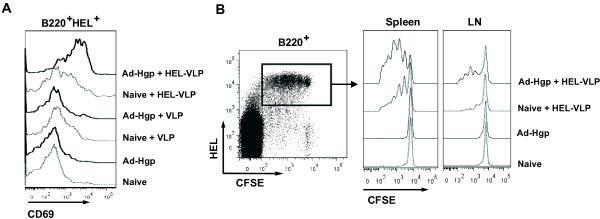
Activation and proliferation of HEL specific B cells exposed to HEL-VLPs. (A) Naïve B-cells from SW-HEL mice were co-cultured for one day with splenic DCs and CD4+ T-cells from either non-immunized (naive) or GagPol immunized (Ad-Hgp) mice in the presence of HEL-VLPs or control VLPs lacking HEL. Cells were stained with Alexa488-conjugated HEL and antibodies to B220 and anti-CD69. The CD69 expression pattern of HEL+B220+ cells is shown. The experiment was performed three times with similar results, data of one representative experiment are shown. (B) Naïve B-cells from SW-HEL mice were labelled with CFSE and adoptively transferred into non-immunized or GagPol-immunized mice. Two hours later, half of the acceptor mice were injected i.v. with HEL-VLPs. Three days later, spleen and LN cells were stained with Alexa647-conjugated HEL-and anti-B220 antibodies. The CFSE fluorescence intensity of HEL+B220+ cells is shown. Two independent experiments with three to four mice were performed. Representative data are shown.